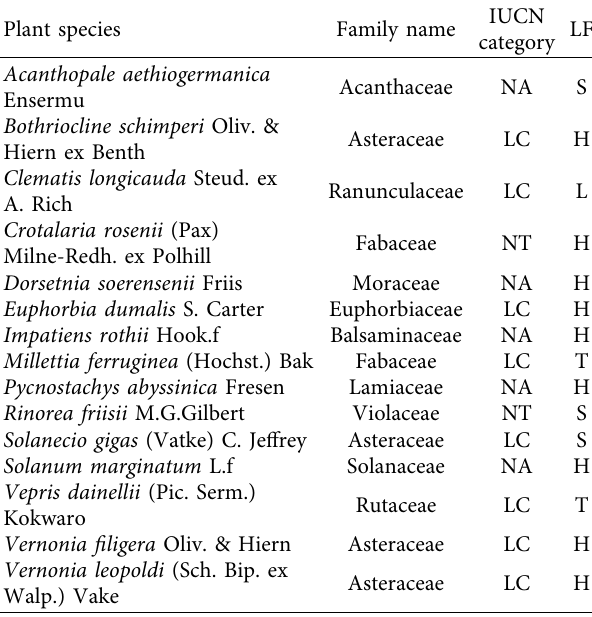
Table 4: Endemic plants, their habits, and IUCN status in the Majang Forest Biosphere Reserve.